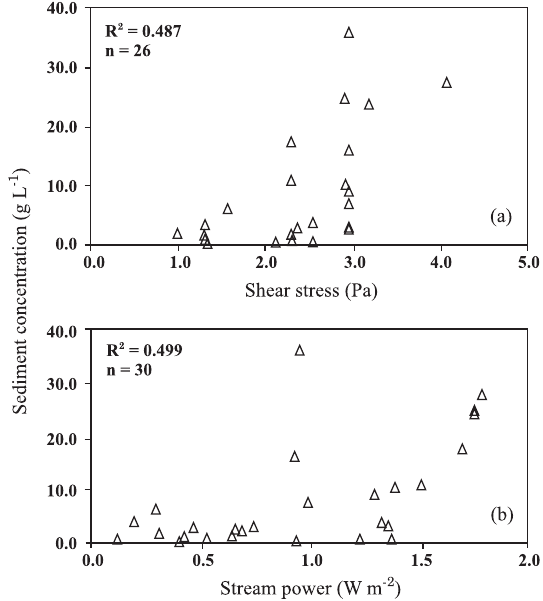
figure 2. Relationship between the hydraulic pa- rameter and the sediment concentration: (a) shear stress and (b) stream power.